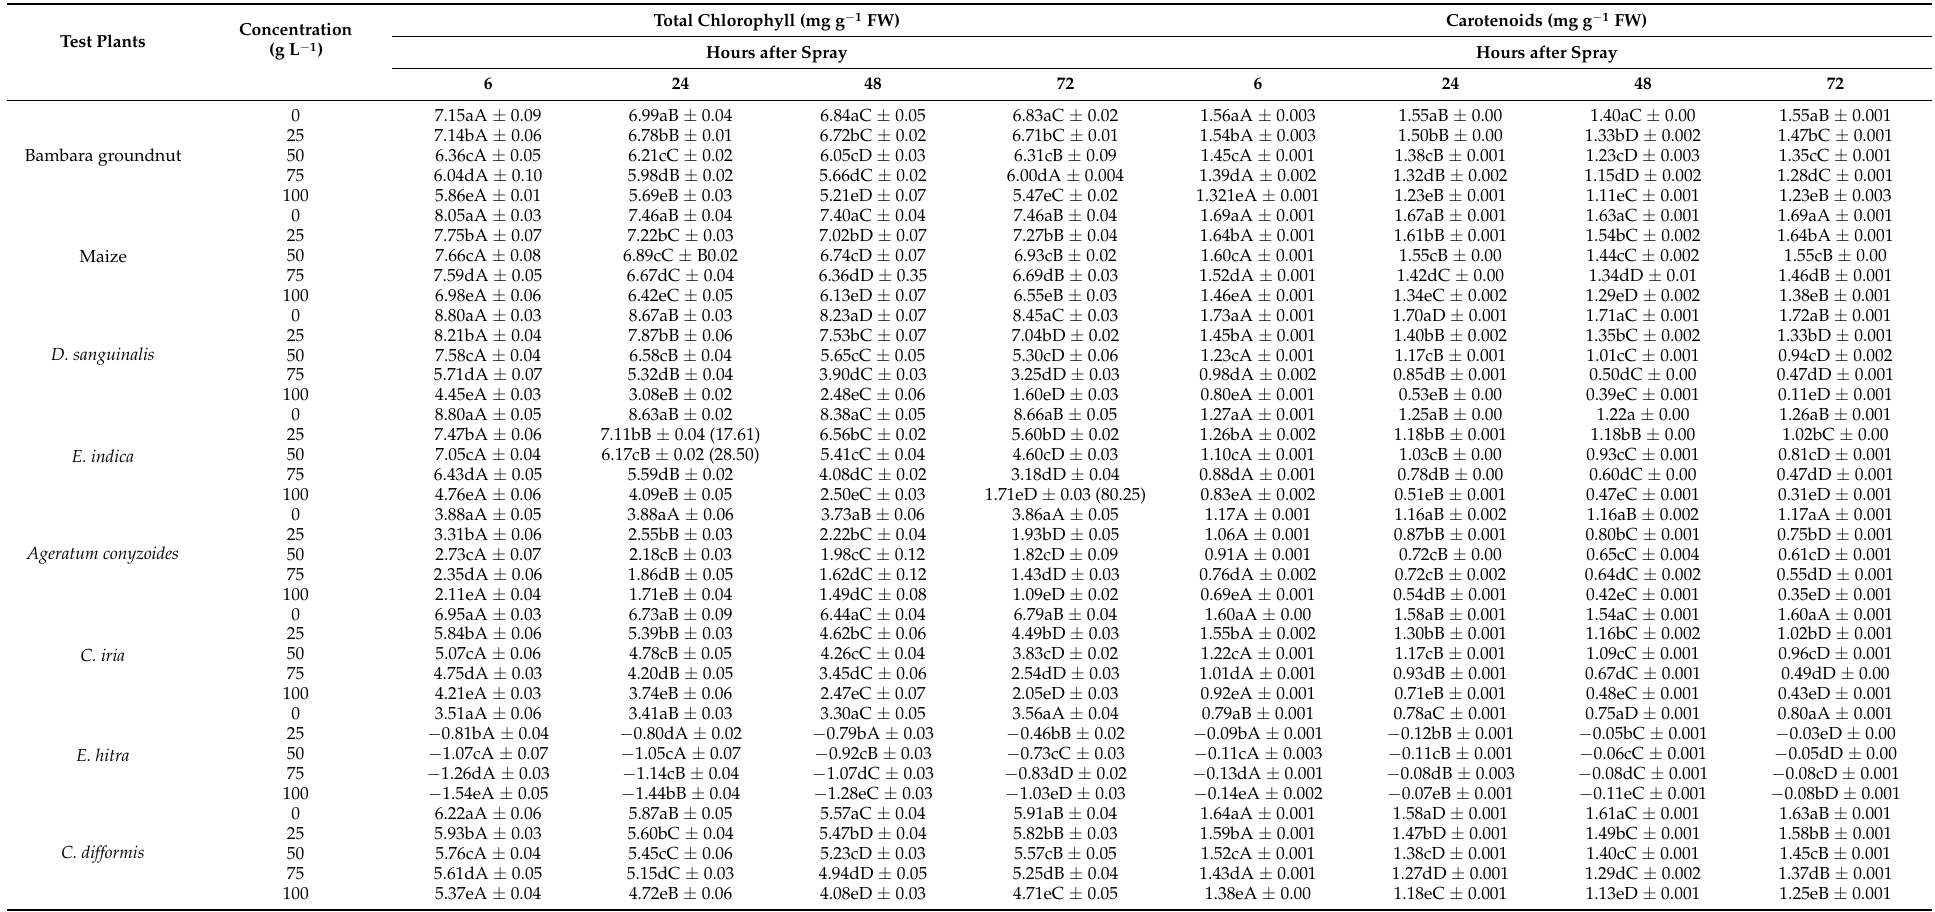
Table 4. Response of total chlorophyll content and carotenoids as a consequence of foliar spray of P. hysterophorus leaf extract on several crops and